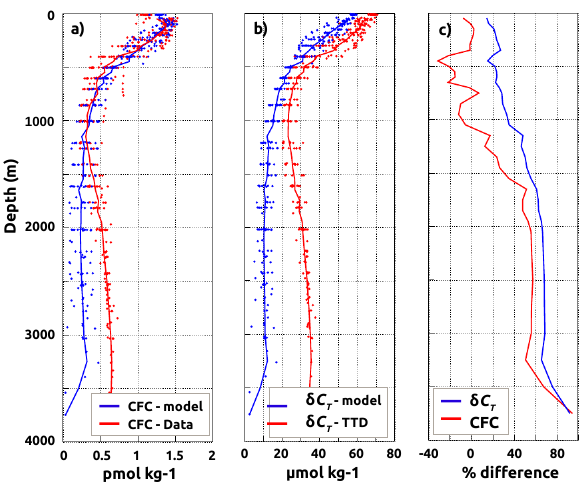
Figure 5. Comparison of average vertical profiles along the Meteor M51/2 section for (a) CFC-12 (pmolkg − 1 ), (b) δC T (µmolkg − 1 ), and (c) the model–data relative difference (in percent). Model re- sults are in blue, while red indicates the CFC-12 data and δC T data- based estimates; the right panel (c) uses blue for δC T and red for CFC-12. Data-based estimates for δC T are the TTD results from Schneider et al. (2010).